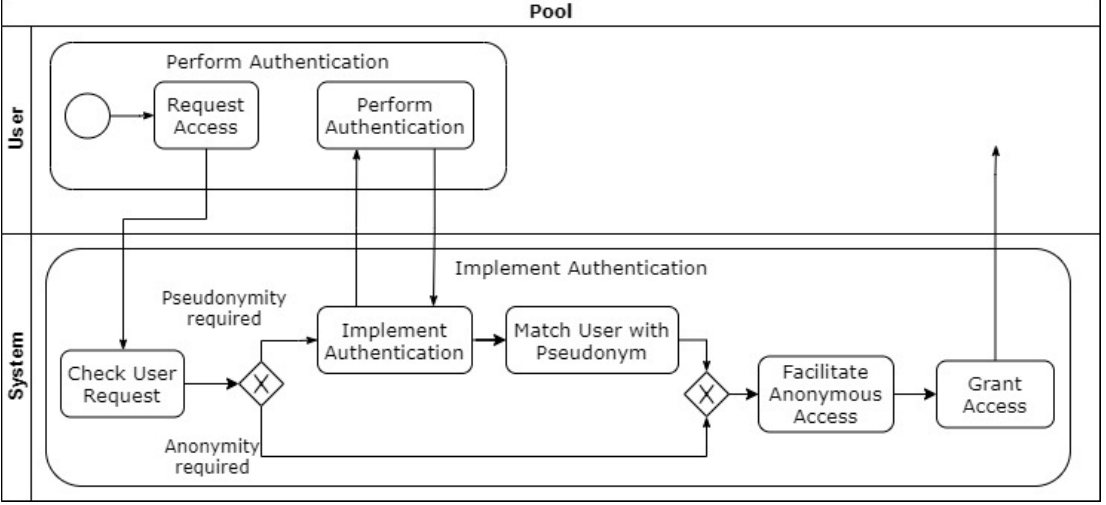
Figure 23. Conceptual overview of Anonymity and Pseudonymity process pattern [49].